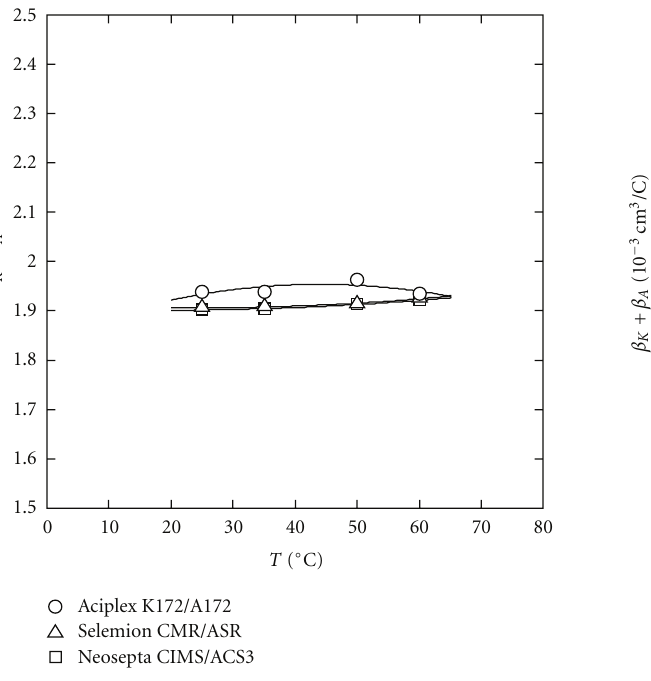
Figure 5: Relationship between temperature and transport num- ber.